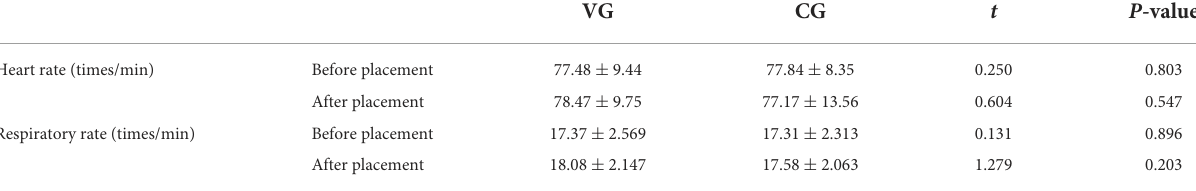
TABLE 4 Complications during tube placement between the two groups ( n